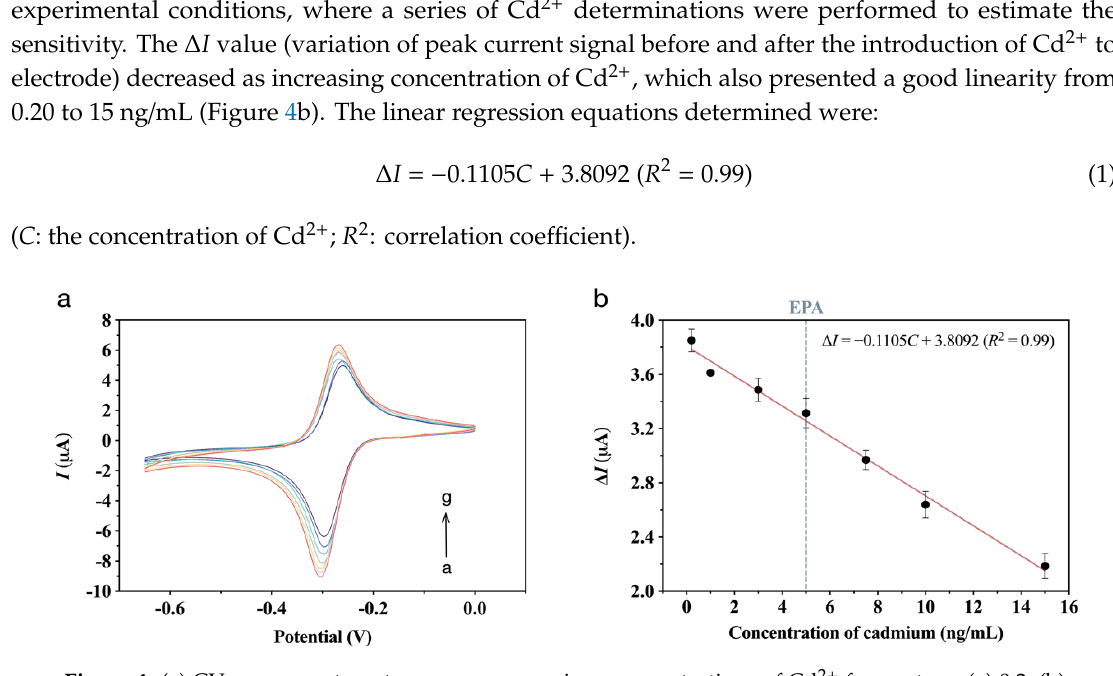
Figure 3. CV of electrode under each assembly procedure from −0.65 to 0.00 V (scan rate: 100 mV/s): ( a ) bare electrode, ( b ) electrode modified with Co 2 Ti 1 , ( c ) electrode modified with Co 2 Ti 1 /aptamer, ( d ) electrode modified with Co 2 Ti 1 /aptamer/Cd 2+ .